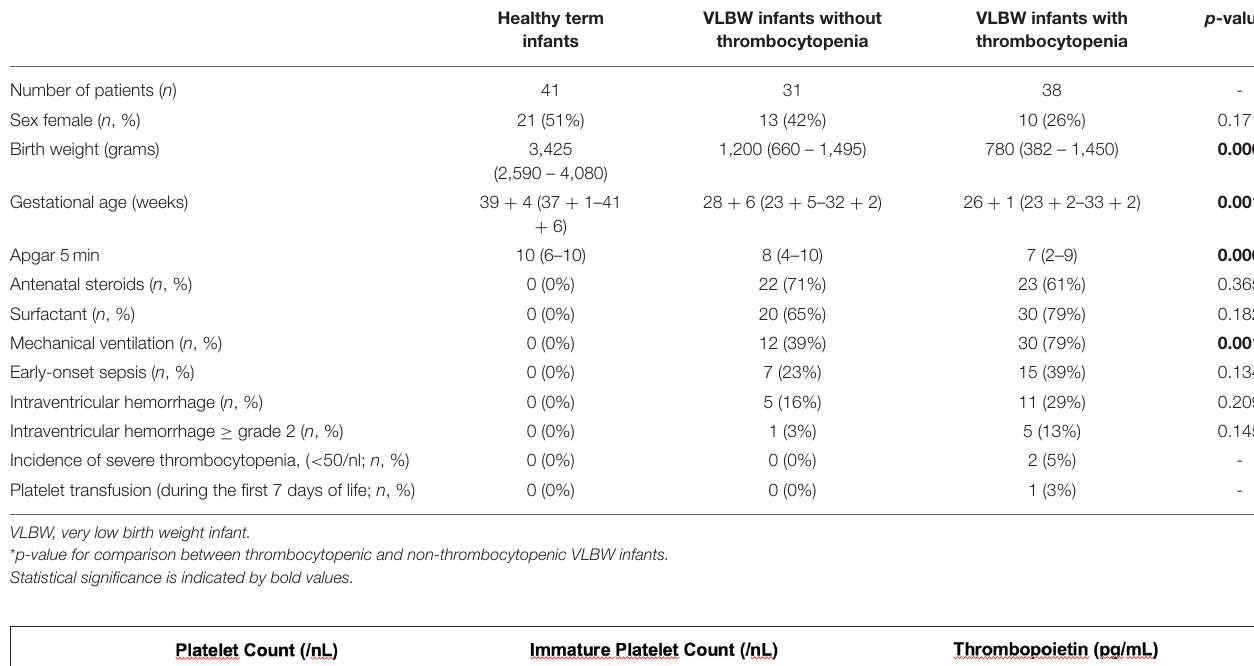
TABLE 1 | Clinical characteristics of healthy term and preterm VLBW infants with and without early-onset thrombocytopenia.